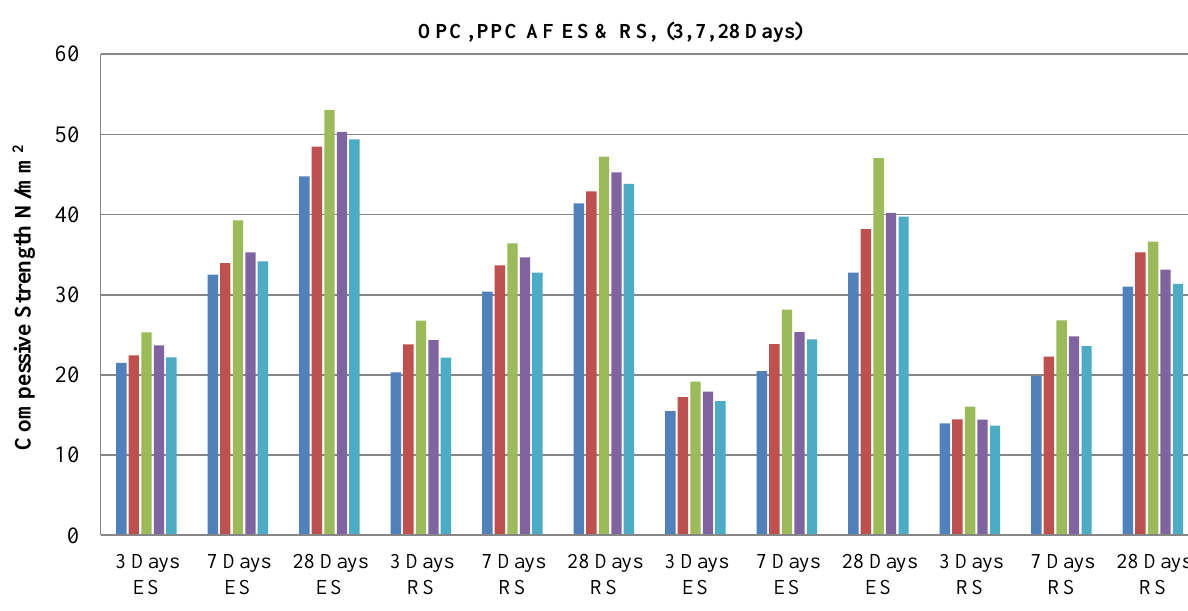
Figure 20. Total comparison of compressive strength at all age of OPC PPC AF ES &